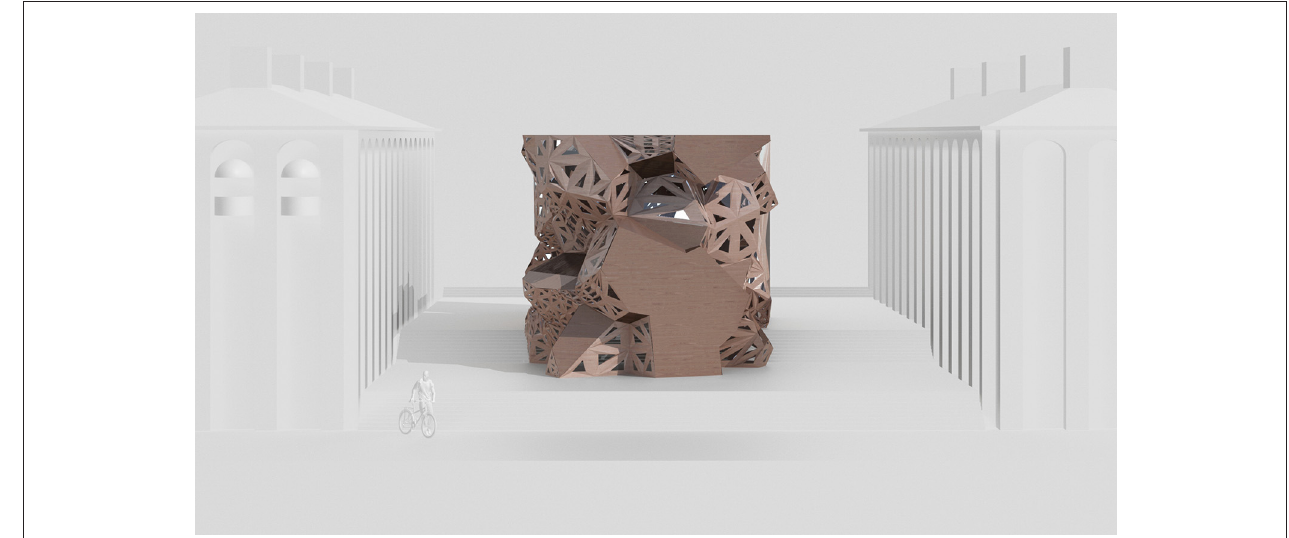
FIGURE 15 | Rendered 3d model of the final teleodynamically designed building